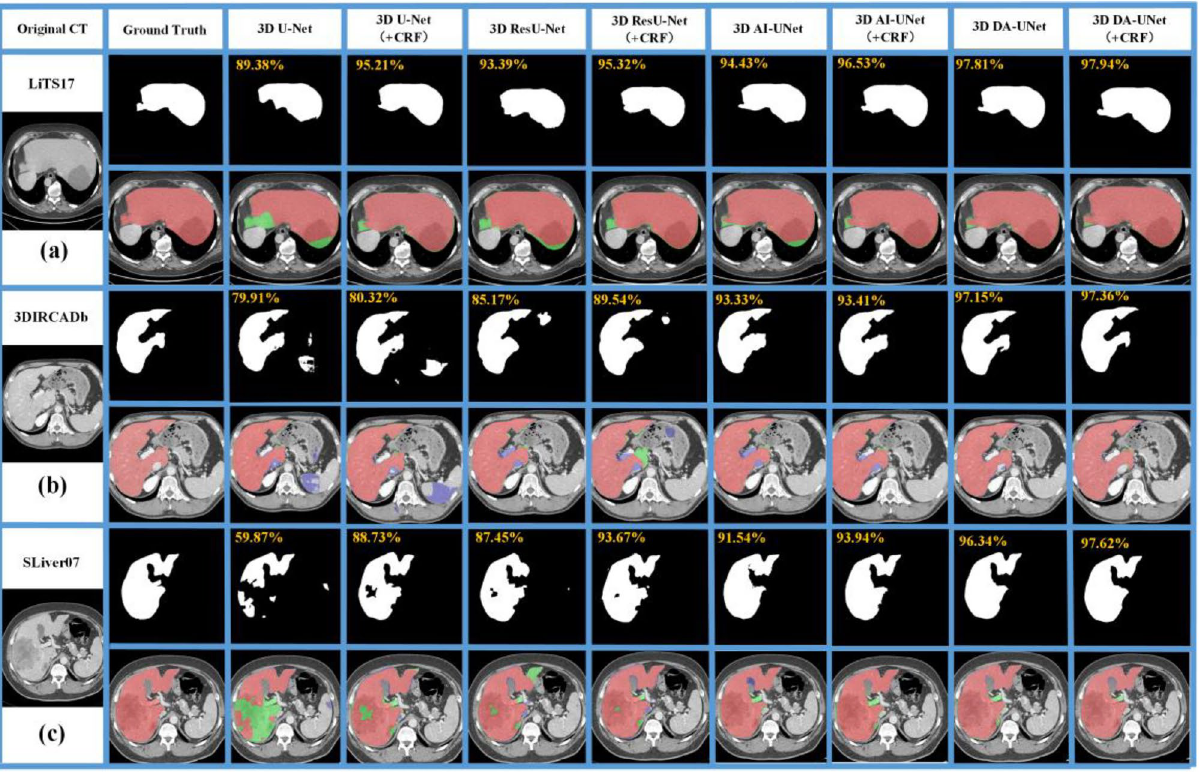
Figure 4. Visualization of the ablation experiments (The red region denotes the ground truth, blue/green region represents the under-/over-segmentation) ( a ) liver adjacent to other organs ( b ) liver adjacent to other organs ( c ) liver with border tumor.